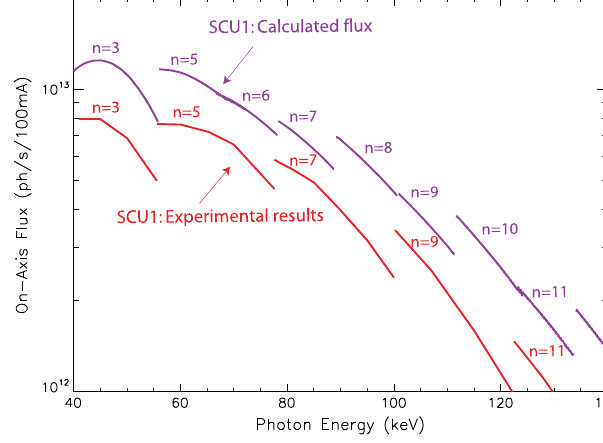
FIG. 20. Comparison of measured and expected SCU1